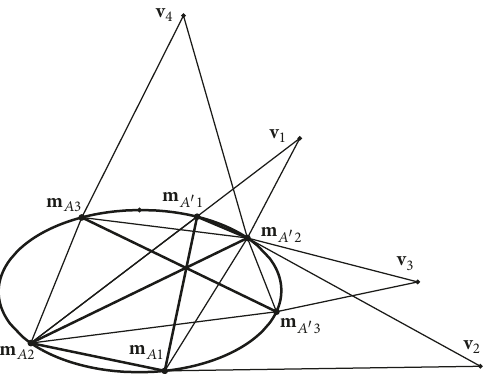
Figure 2: Using the image of the calibration template to solve for the orthogonal vanishing points k 𝑗 and 𝑗 = 1, 2,3, 4 .